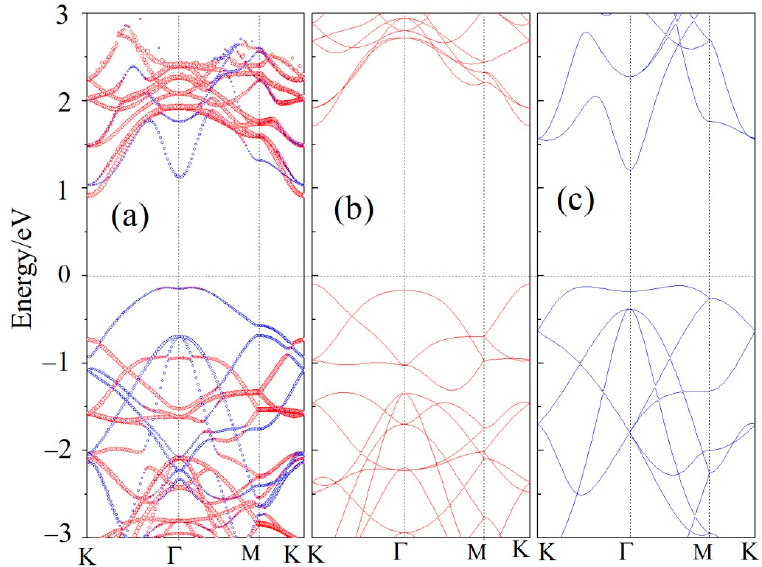
Figure 2. The band structure of the arsenene/WS 2 heterostructure ( a ), WS 2 ( b ), and arsenene ( c ). The blue and red lines represent the bands of arsenene and WS 2 , respectively.